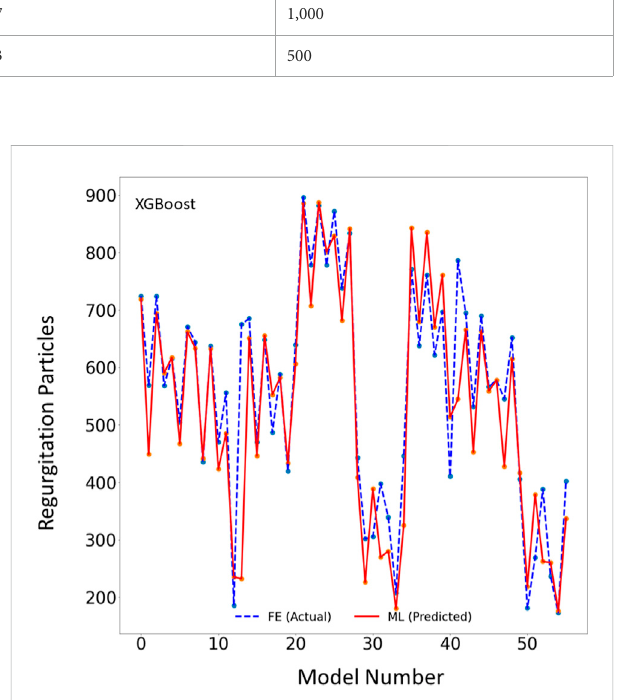
FIGURE 2 The MR results for the test set obtained from FE (ground truth) and XGboost (predicted). The MR is computed based on the blood particles that leaked into left atrium. Python (3.7, https://www.python. org/) was used to create this fi